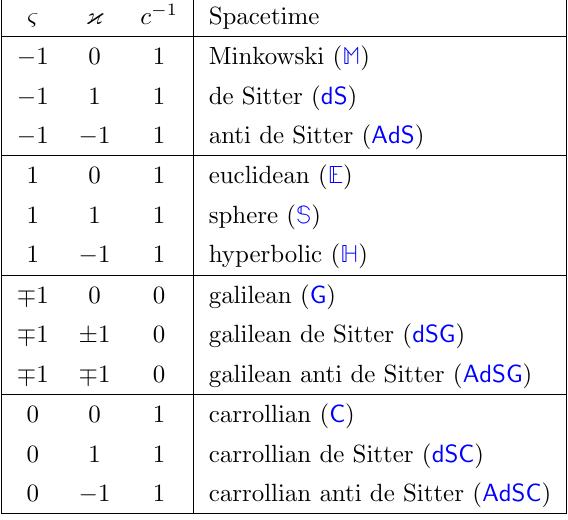
Table 4 . Symmetric